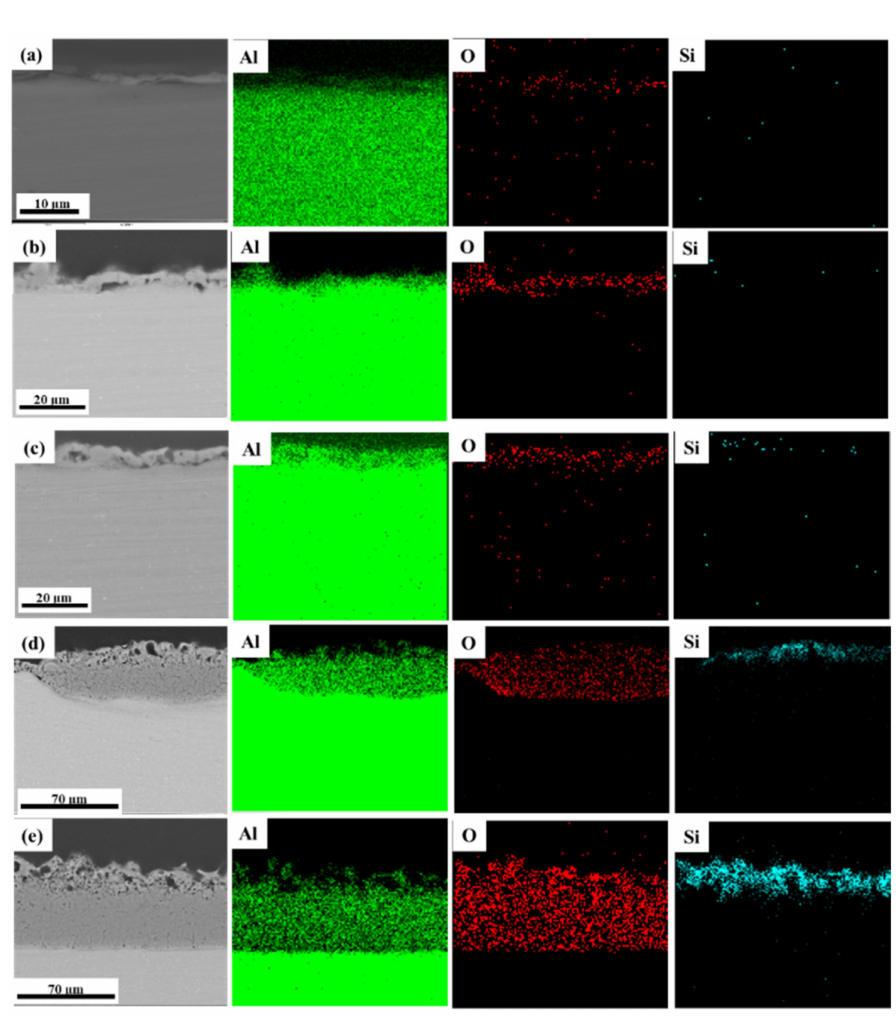
Figure 6. EDS mapping images of PEO coatings at different stages: ( a ) stage I; ( b ) stage II; ( c ) stage III; ( d ) early period of stage IV; ( e ) later period of stage